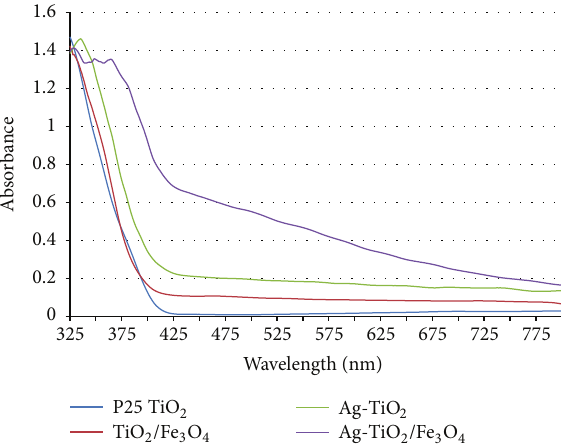
Figure 1: XRD spectra of Ag-TiO 2 /Fe 3 O 4 . Figure 2: UV-Vis diffuse reflectance spectra for the as-synthesized